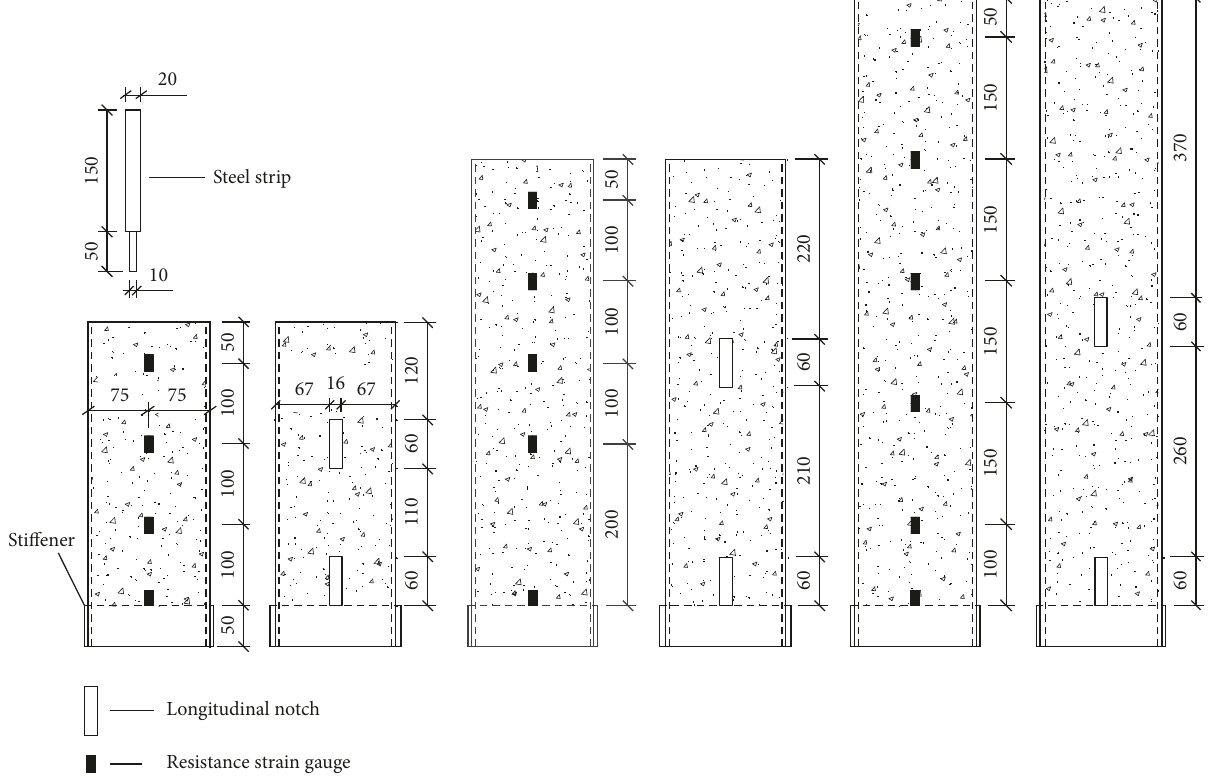
Figure 1: Distribution of steel strips, resistance strain gauges, and longitudinal notches